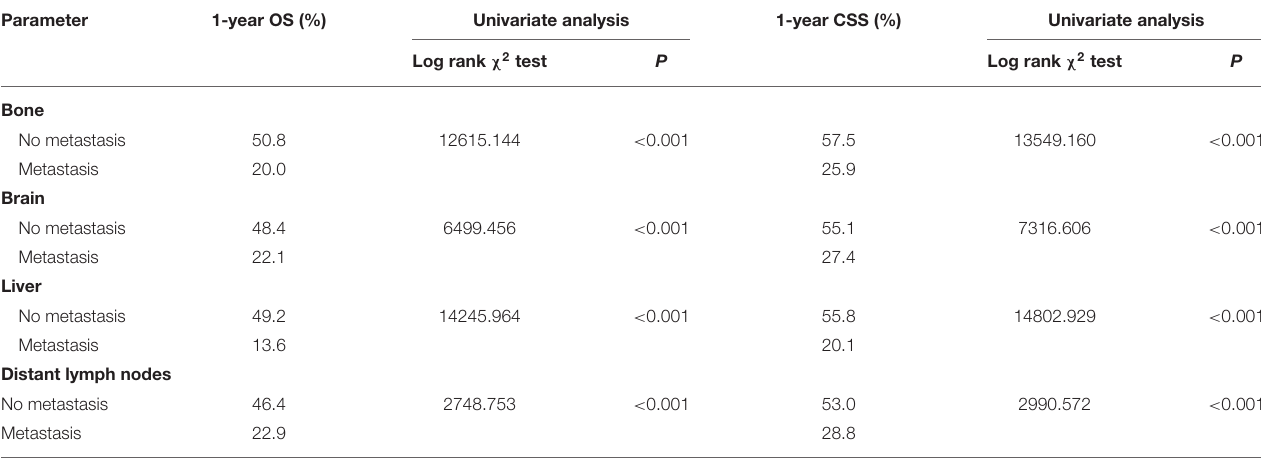
TABLE 2 | Survival analysis in diverse metastatic organs.